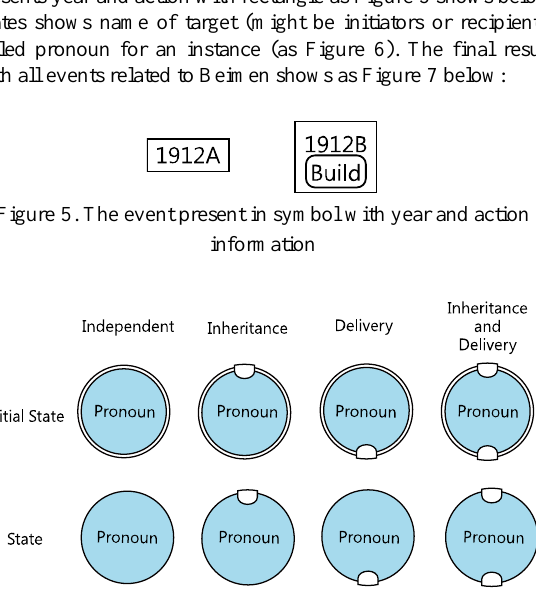
Figure 6. Difference kind of state in event chain